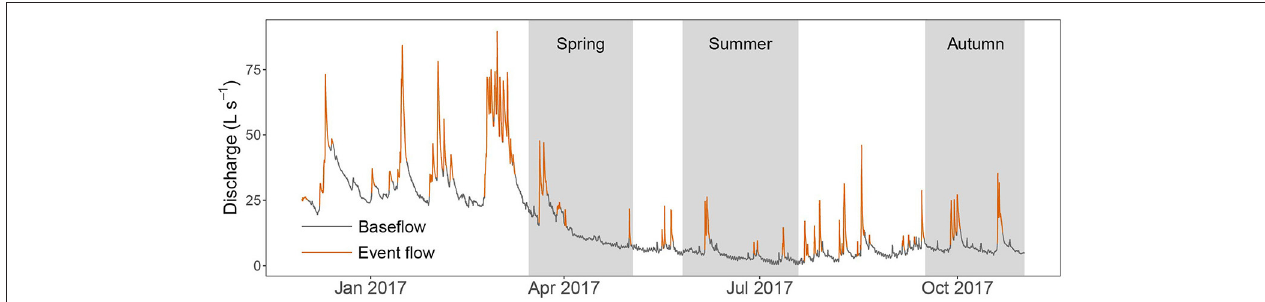
FIGURE 2 | Discharge (hourly time step) of the study stream throughout the monitoring period. Baseflow and event flows are denoted by grey and orange lines, respectively. Grey bars show periods when nutrient sensors were deployed.